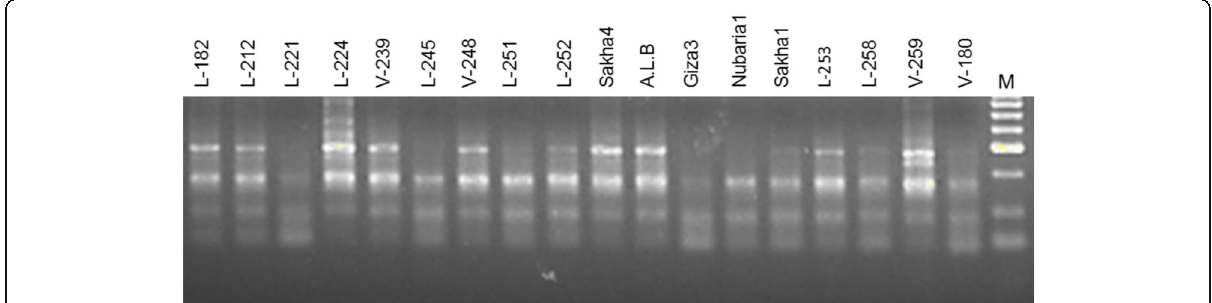
Fig. 3 Amplified products of SRAP marker using primer 3 for analyzing 18 faba bean